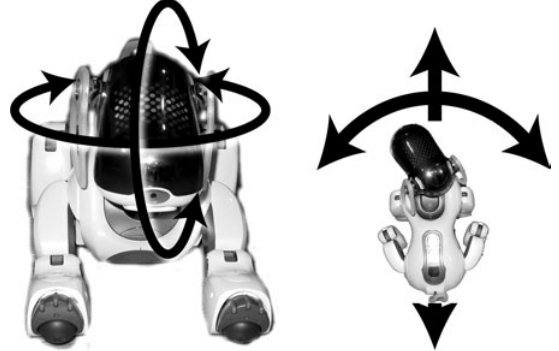
Figure 4 AIBO control command.